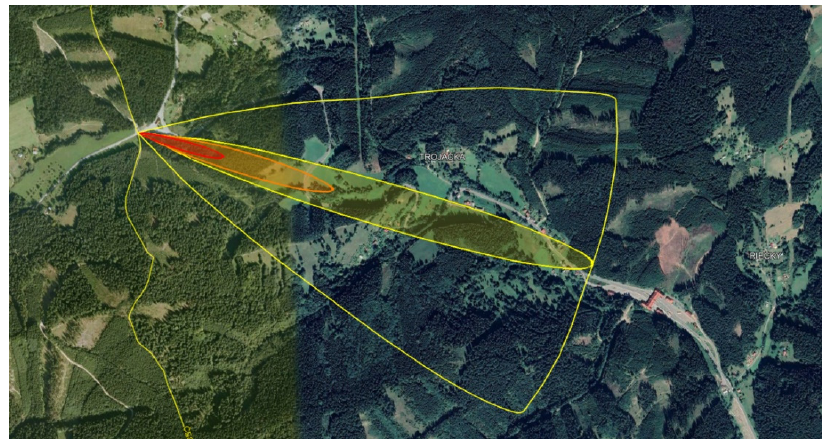
Figure 2. Graphical representation of the dispersion of a dangerous substance at the Makov border crossing [24,25].